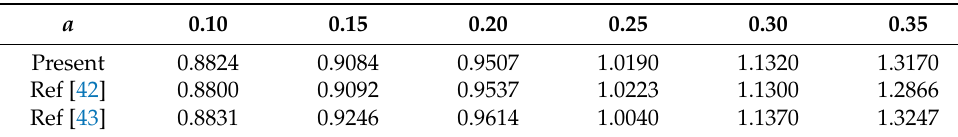
Figure 10. ( a ) A crucifix crack in a square plate under bi-axial tension; ( b ) Global and local meshes (the total number of elements is 580, DOF = 36,206). Table 10. Normalized SIFs F I for a crucifix